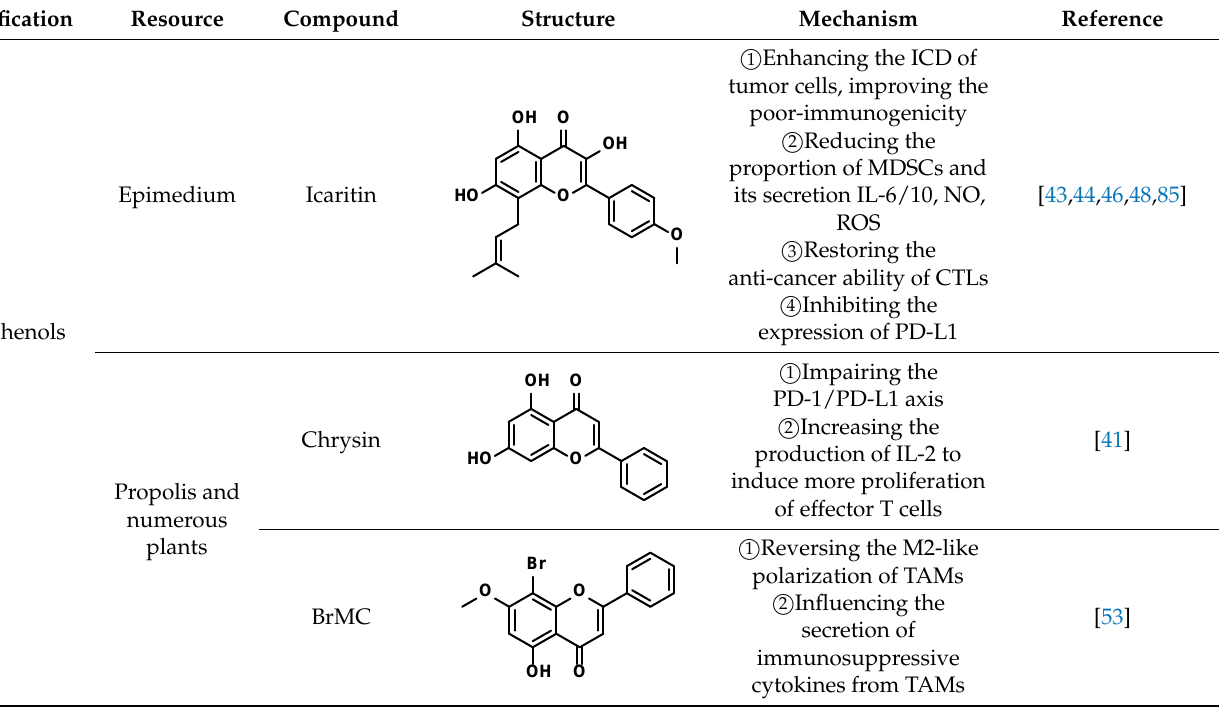
Table 1. The application of natural products in hepatocellular carcinoma (HCC) immunotherapy.